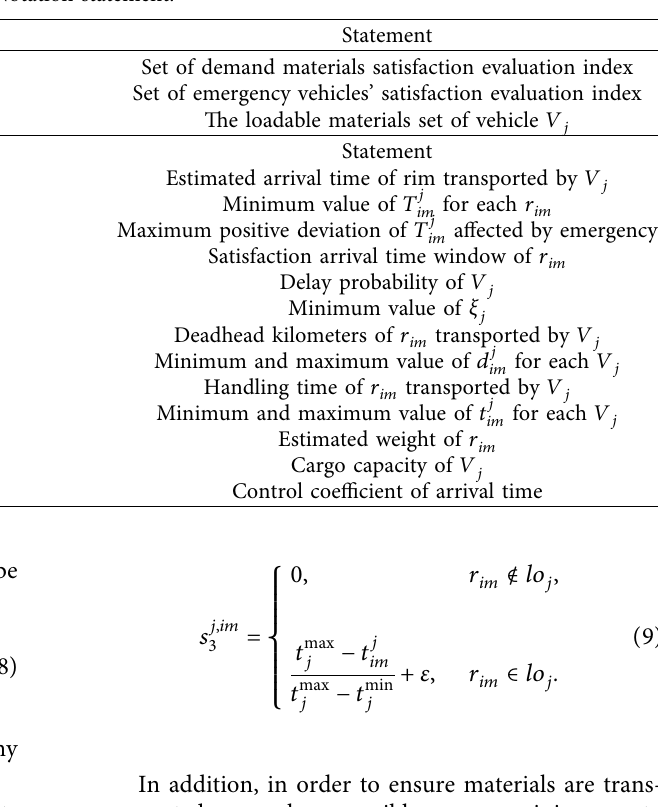
Table 1: Notation